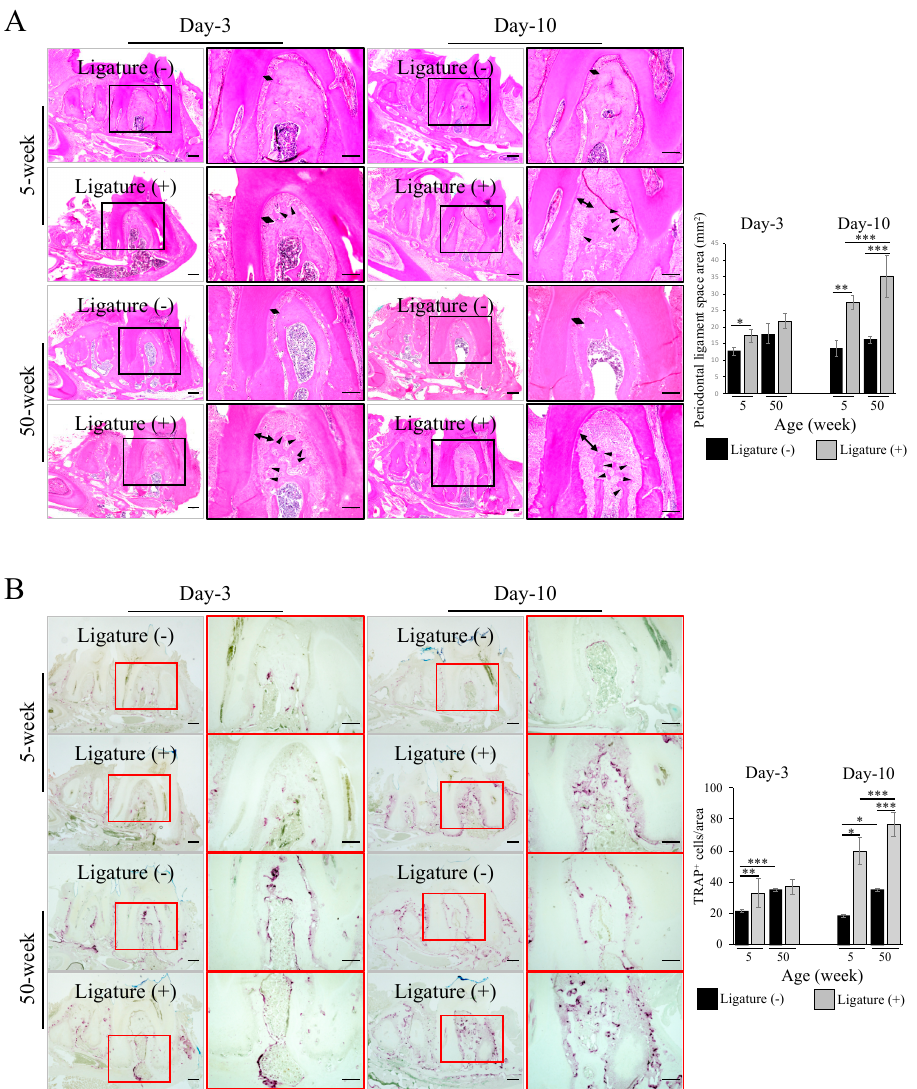
Figure 2. Increased periodontal space and osteoclast activity in the ligation-induced periodontitis in aged mice. ( A ) Hematoxylin and eosin HE staining showing the widening of the periodontal ligament space (bidirectional arrow) in both young and aged mice at day-3 and day-10 after ligation. Note a more severe bone loss and small pits (arrowhead) in aged mice (Black box indicated magnified area in HE staining). Bar: 100 µm. ( B ) Tartrate-resistant acid phosphatase TRAP staining confirming the higher number of TRAP + cells (purple) in the furcation area of the mandibular first molar in aged mice at day-10 after ligation (Red box indicated magnified area in TRAP staining). Bar: 100 µm. The bar graph represents the mean ± standard deviation of at least 3 independent samples. * p < 0.05, ** p < 0.01, *** p < 0.001, two-way ANOVA, Tukey test, n = 3.